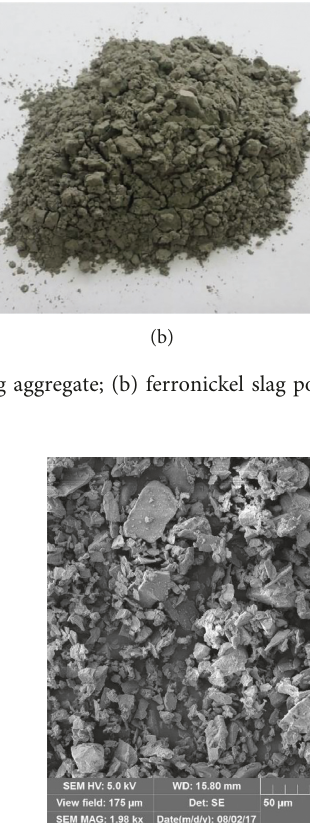
Figure 2: SEM image of ferronickel slag powder. Table 1: Chemical composition.